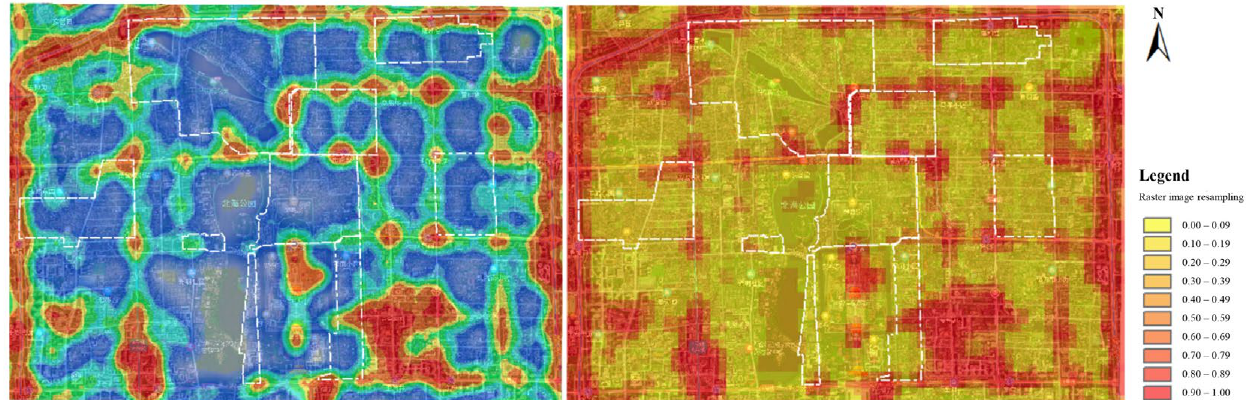
Figure 3. Baidu heat map original (left) and vector heat map hierarchical display (right).